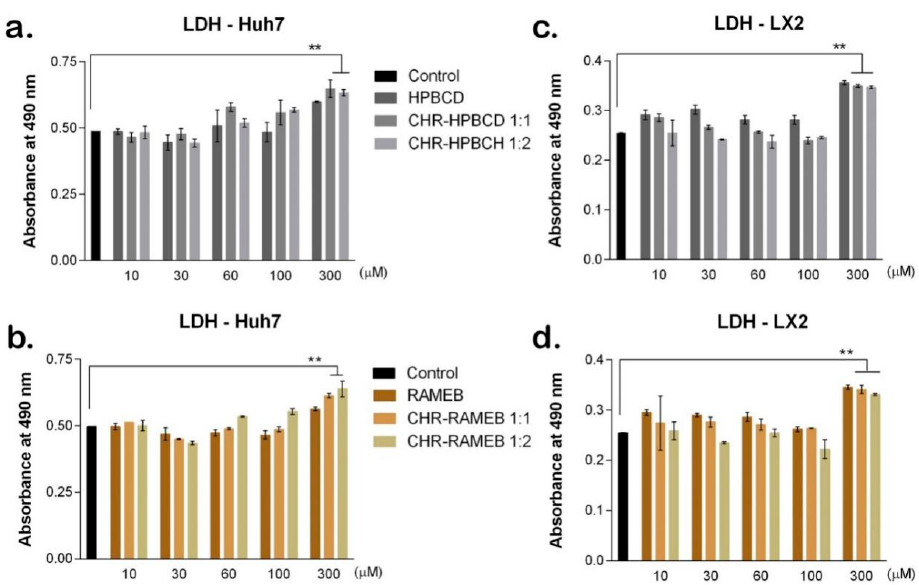
Figure 2. CD–CHR cytotoxicity induced on Huh7 and LX2, evaluated by quantitative LDH test. Statistical significance: * p < 0.05; ** p < 0.01; ( a ) Cytotoxicity induced by HPBCD complexes on Huh7; ( b ) Cytotoxicity induced by HPBCD complexes on LX2; ( c ) Cytotoxicity induced by RAMEB